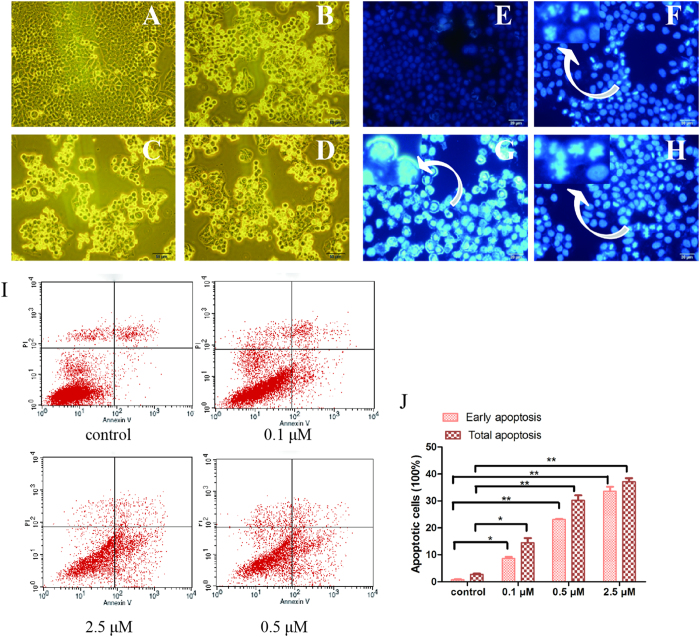
CPUY201112 induces MCF-7 cell apoptosis.(A–D) Morphological changes of cancer cells and nuclei. (E–H) MCF-7 cell apoptosis was induced by CPUY201112. Cultured MCF-7 cells were treated with CPUY201112 at the indicated concentrations for 48 h. The cells were then were stained with DAPI and observed by fluorescence microscopy. (A,E) Control. (B,F) 0.1 μM. (C,G) 0.5 μM. (D, G) 2.5 μM. (I) CPUY201112 induces apoptosis in a dose-dependent manner. MCF-7 cells were treated with different concentrations of CPUY201112 for 48 h, and Annexin V and propidium iodide staining was performed. (J) The early apoptosis and total apoptosis percentages were quantified using flow cytometry. *p < 0.05; **p < 0.01.